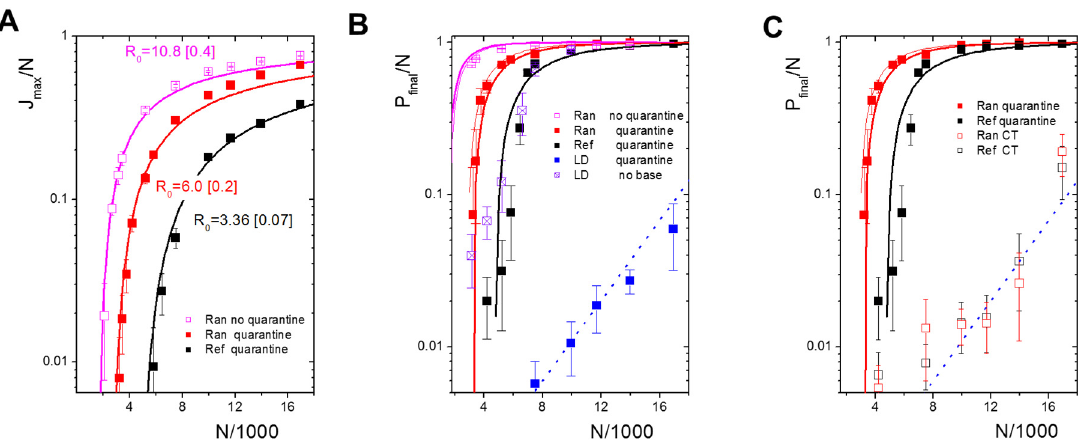
Figure 2. Characteristics of the epidemic for different agent numbers and mobility. ( A ) Maximum fraction of infected agents, J max / N , for the random jump model (Ran) with F A = 1 (pink). Quarantine of symptomatic agents ( F A = 0.5, red) and reduction of mobility (Ref, black) decrease the maximum for all N . Symbols are simulation results, lines represent the SEIR solutions with fitted R 0 . ( B ) Final size of the epidemic, P final / N . Symbols are simulation results, solid lines represent the SEIR solutions with fitted R 0 (thick) and analytical R 0 (thin, for Ran results only). The blue dotted line is an exponential growth curve for the subcritical regime. Reference mobility (Ref) keeps the epidemic under-critical up to an agent number of about 5000. LD20 mobility (blue) extends the subcritical regime beyond N ref . Loss of the base position at LD20 mobility (violet) abrogates the LD effect. ( C ) Applying CT keeps the epidemic under-critical for N < N ref . Thus, it has a similar effect on P final / N as a LD20. Lines as in ( B ). All errors: sd.